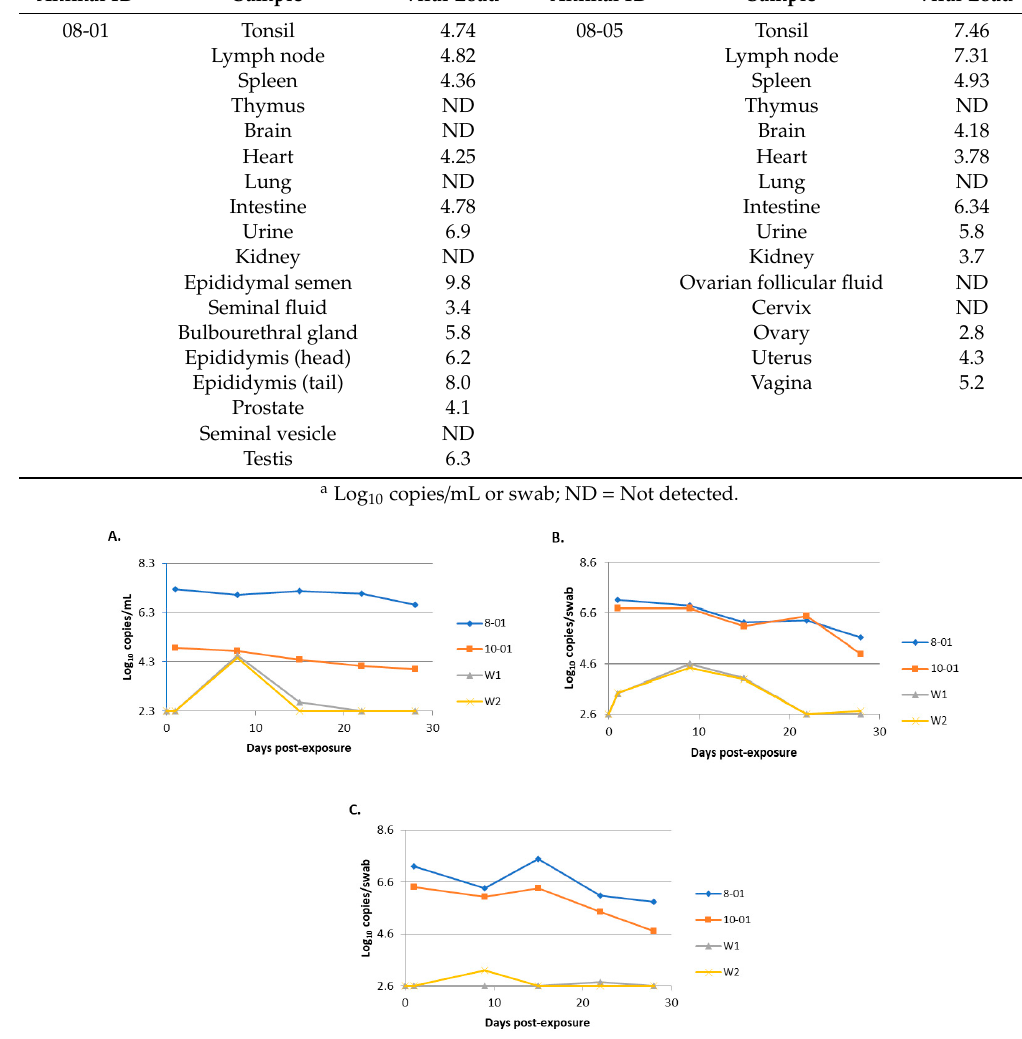
Figure 7. Comparison of the quantity of virus detected in serum ( A ), oropharyngeal swabs ( B ) and rectal swabs ( C ) for persistently infected (PI) animals (8-01 and 10-01) and transiently infected in-contact animals (W1 and W2).